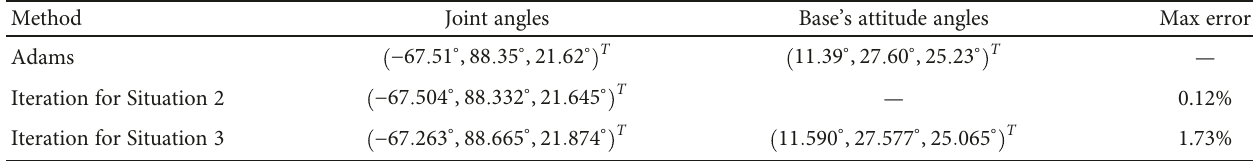
Table 3: Simulation results of the Adams simulation and the iterations for the spatial